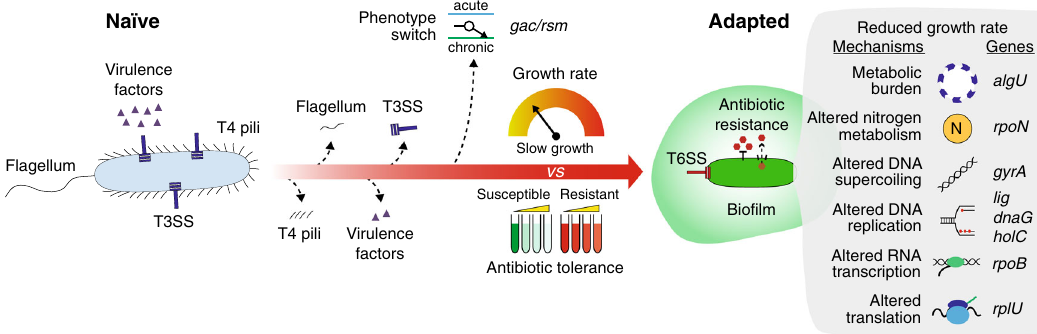
Fig. 6 Trajectory of adaptation of Pseudomonas aeruginosa to the cystic fi brosis (CF) environment. The cartoon represents the trajectories of evolution from naïve to adapted strain occurring in the CF patients. Several cellular components such as the fl agellum, the type 4 pili (T4 pili), the type 3 secretion system (T3SS) and numerous virulence factors are lost during within-patient evolution due to accumulation of mutations. The Gac/Rsm regulatory system coordinates the switch between acute and chronic phenotype through changes of gene expression pro fi les. Meanwhile, a reduction of the growth rate occurs due to: (1) metabolic burden caused by algU regulator overexpression; (2) altered nitrogen metabolism caused by mutations in rpoN and caused by changes in the RpoN regulon transcriptional pro fi les; (3) altered DNA supercoiling caused by gyrA gene mutations; (4) altered DNA replication caused by mutations on important component of the DNA polymerase ( lig , dnaG , holC ); (5) altered transcription caused by rpoB gene mutations; and (6) altered translation caused by mutations in ribosomal proteins genes. Such reduction in growth rate determines an increased tolerance to antibiotics which fi nally helps P. aeruginosa to persist in the CF